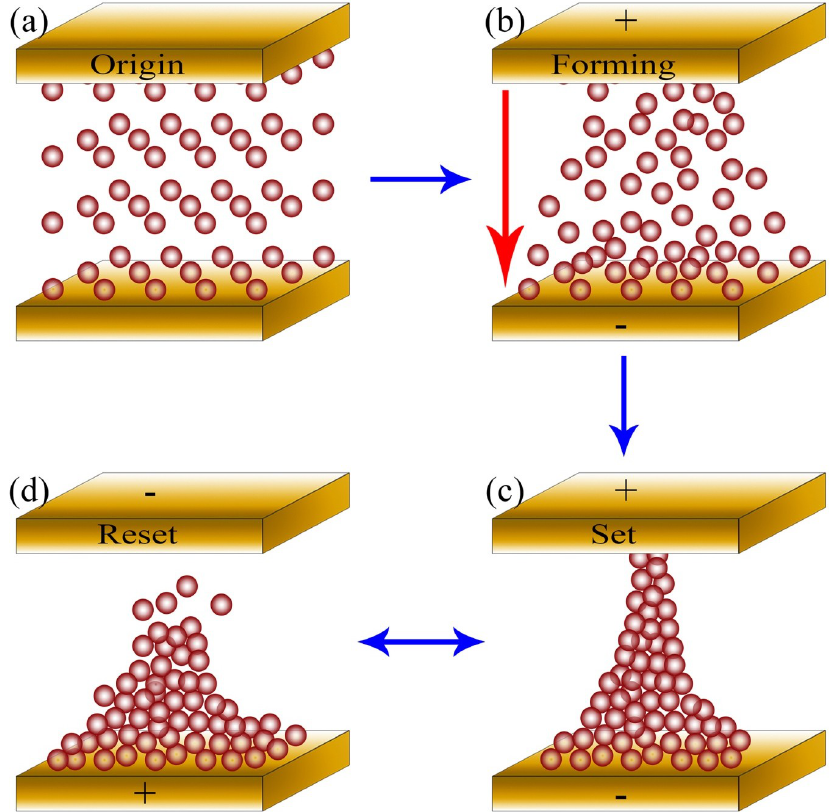
Figure 8. Schematic diagram explaining the conduction mechanism: ( a ) The RS is very high because the device does not form CF; ( b ) When a positive bias is applied, the oxygen vacancies move towards the negative electrode and a CF is formed; ( c ) The device is in the SET state because the oxygen vacancies has formed CF; ( d ) When the voltage is reversed, the CF immediately